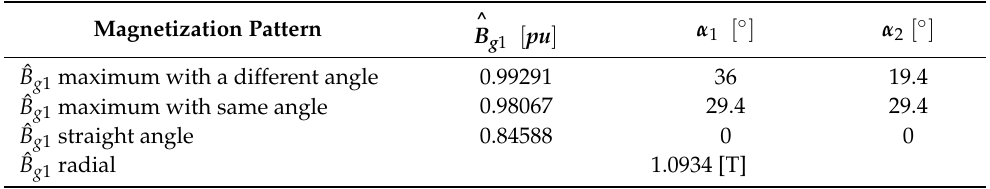
Table 5. Peak fundamental flux density result and corresponding tilt angles normalized to radial magnetization value.